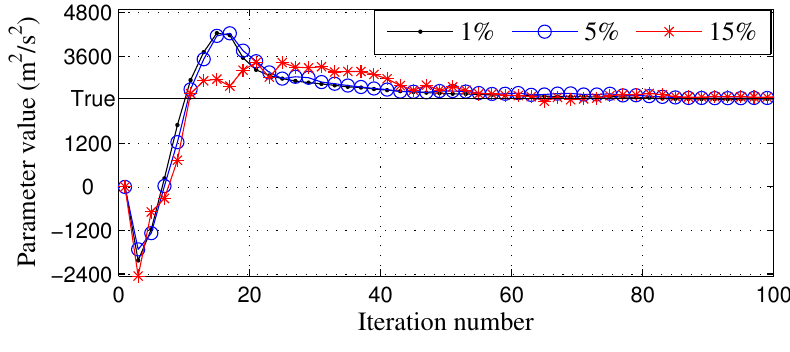
Figure 13. Convergence of the density parameter, ϕ 2 , for different measurement noise